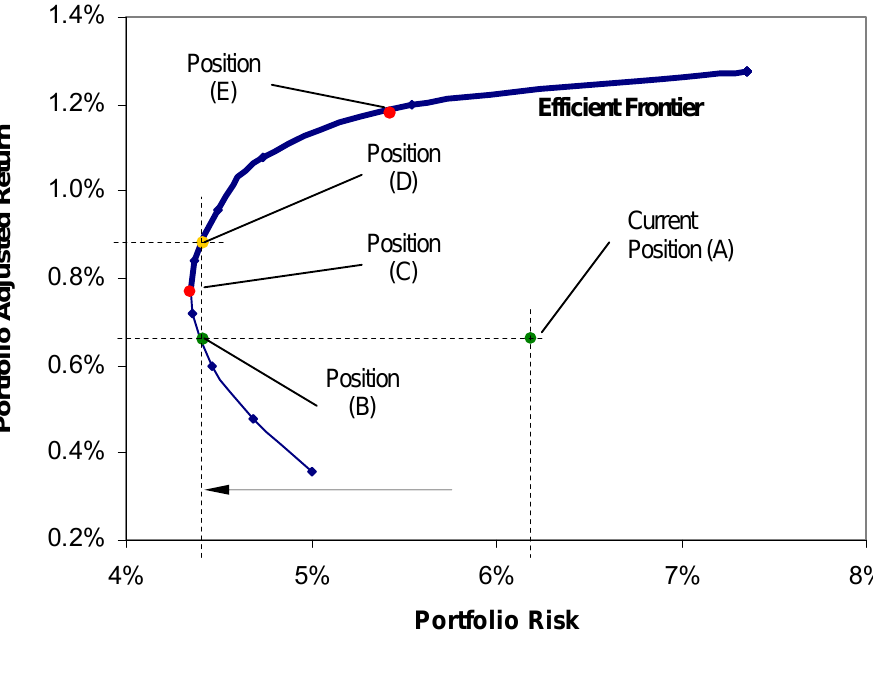
Figure 7 - Efficient